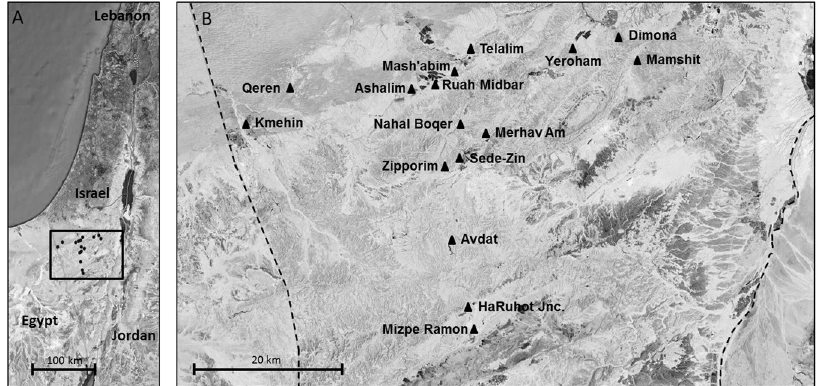
Figure 1. ( A ) Map of study sites (black dots) in the Israeli Negev with a marked section. ( B ) Enlargement of a map section of the Negev Desert Plateau with study sites (black triangles). Exact location of field sites is provided in Appendix A, Table S1. Figure was created using Microsoft PowerPoint 2010 by modifying image from Google Maps (Map data ©2017, Google, Mapa GISrael), retrieved from: https://www.google.co.il/maps/@ 31.5473592,35.4250579,332960m/data = !3m1!1e3?hl =